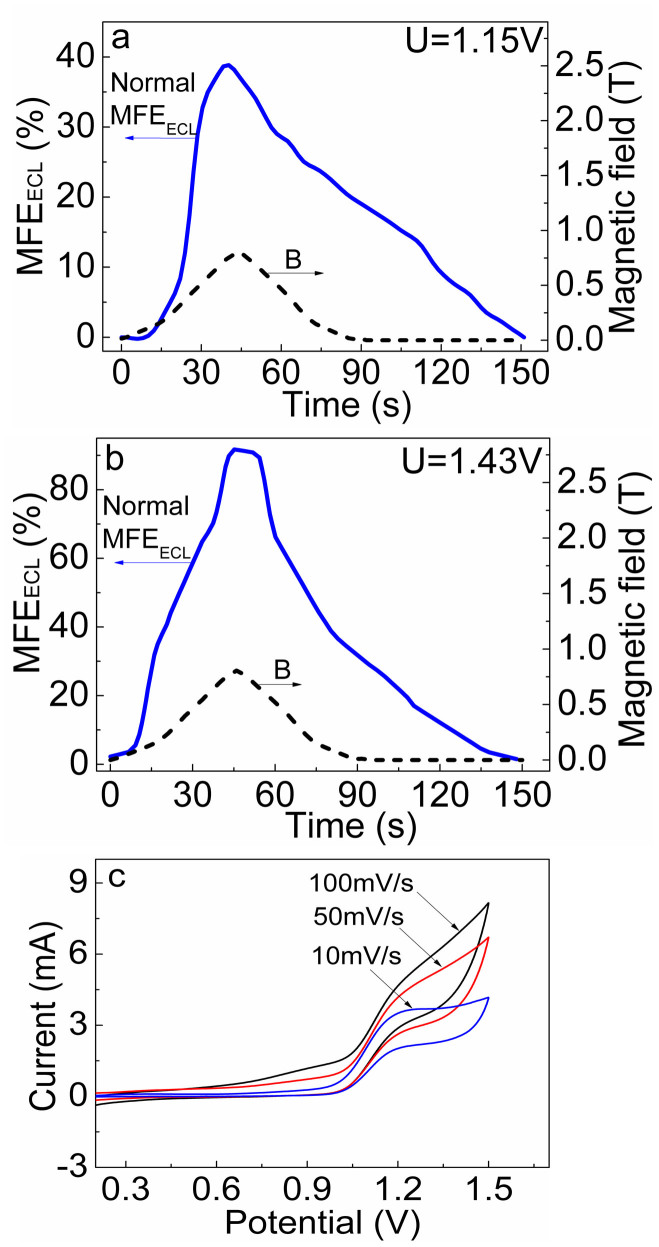
Only normal MFEECL can be observed by slowly increasing electrode potential in the electrochemical (Ru(bpy)3Cl2 + TPrA) system.(a) Electrode potential was set at 1.15 V. (b) Electrode potential was set 1.43 V. (c) Cyclic voltammograms collected at different scanning rates.